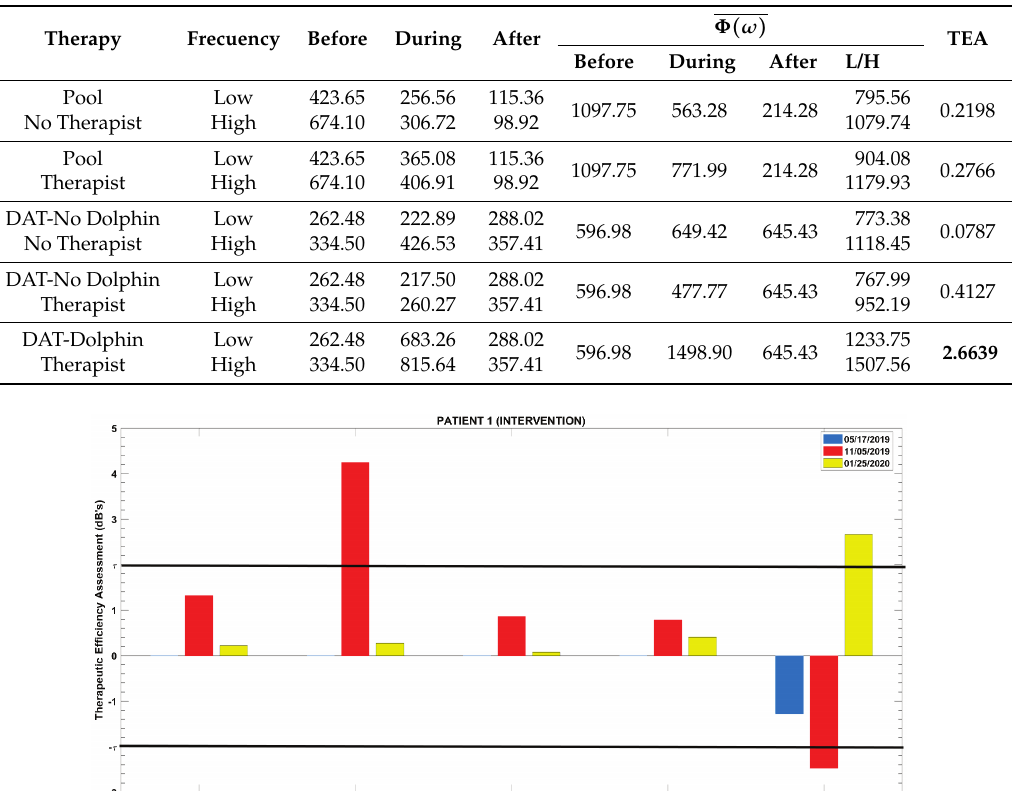
Table 1. Results of the Patient 1 (Intervention), On 01/25/2020 bold type indicates best herapeutic Efficiency Assessment (TEA) (dB).